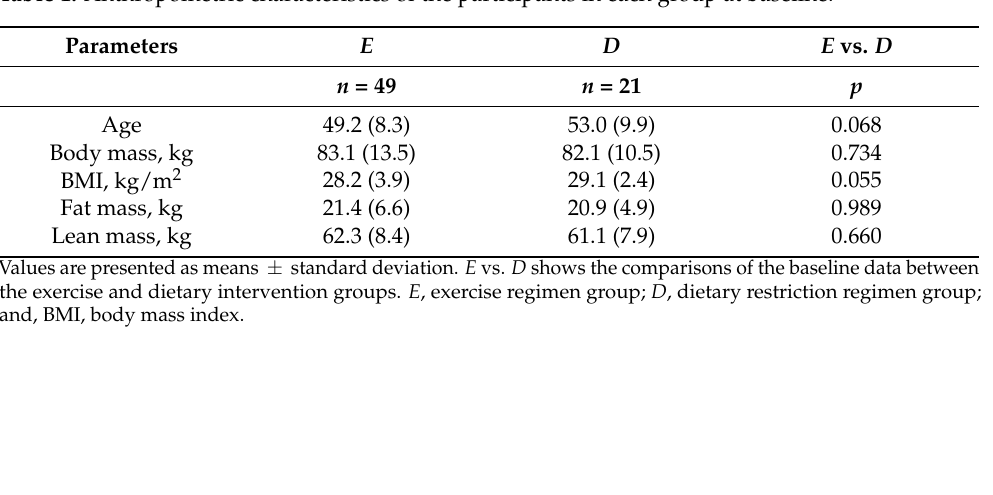
Table 1. Anthropometric characteristics of the participants in each group at